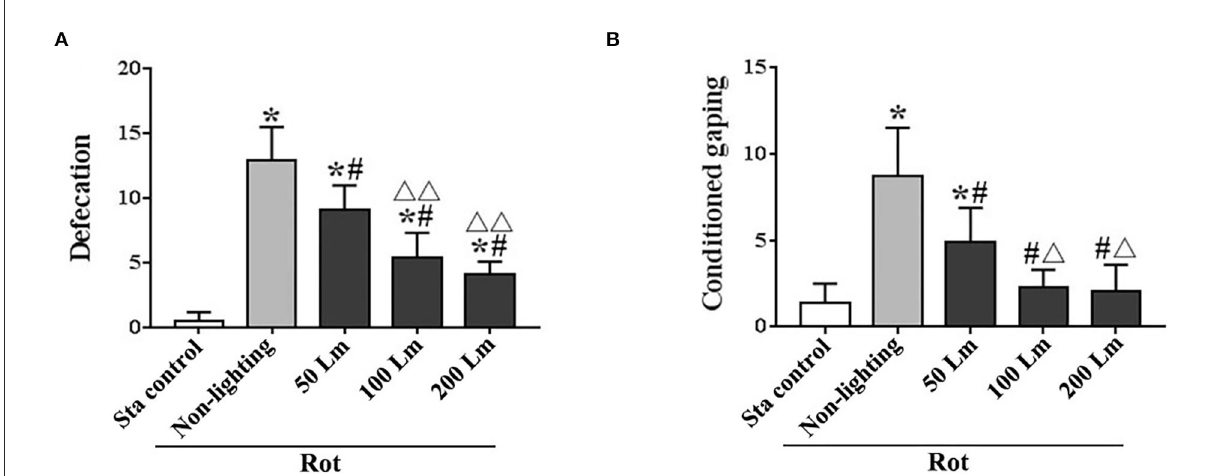
FIGURE4 Effects of synchronized stroboscopic light (6 cycle/min, warm light) with different peak intensities (50, 100, and 200Lm) on defecation (A) and conditioned gaping (B) induced by rotation in rats. Rot, rotation stimulation; Sta, static control treatment. Data are expressed as mean ± S.E. * P < 0.001 vs. the Sta group; # P < 0.001 vs. the Rot non-lighting group. 1 P < 0.01, 11 P < 0.001 vs. the 50Lm Rot group.